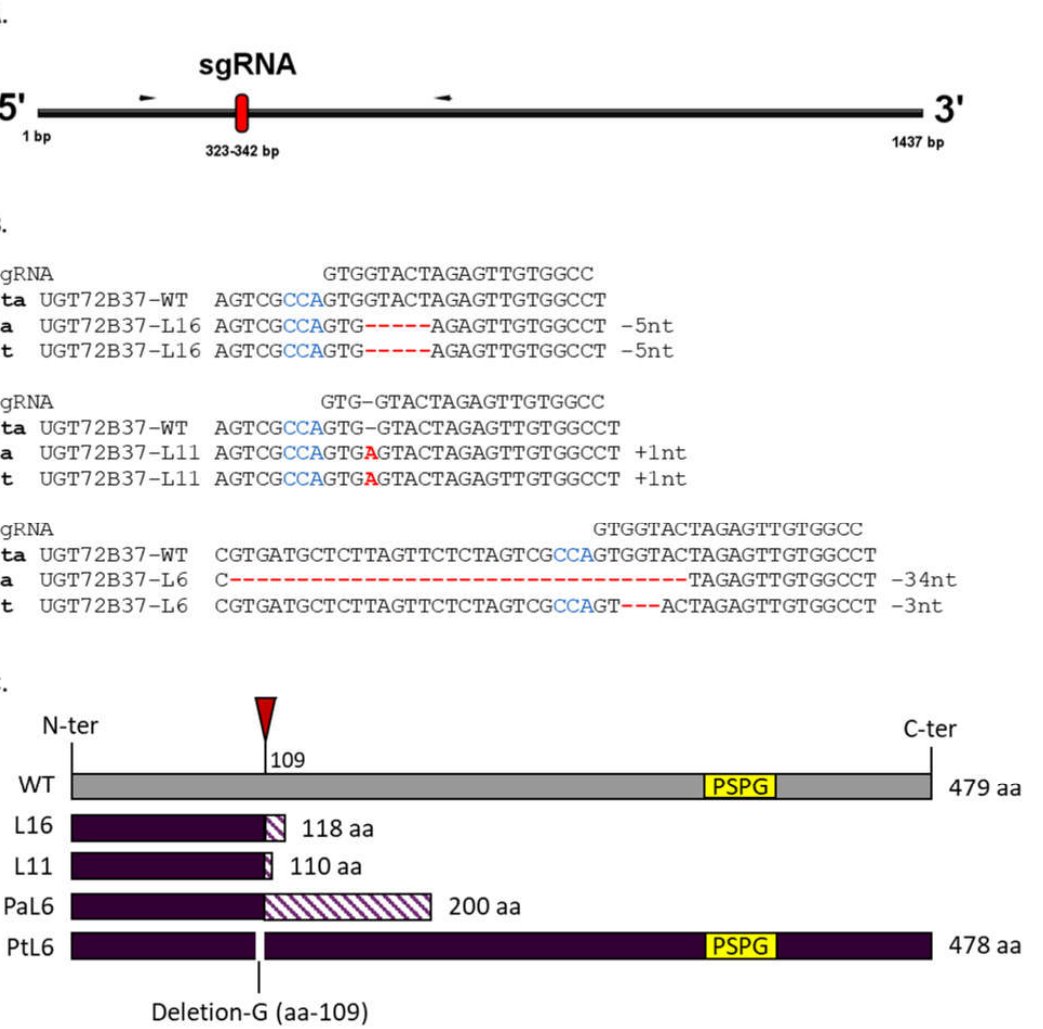
Figure 2. Production of transgenic poplars with CRISPR/Cas9-knockout of UGT72B37 : ( A ) location of the sgRNA target site and the amplified region for sequencing (black arrows, 507 bp in the WT); ( B ) genotypes of the ugt72b37 mutants used in this study. For each independent mutant line (L16, L11, and L6), the genomic modifications of the P. alba (Pa) and the P. tremula (Pt) alleles are indicated in bold red. The protospacer adjacent motif sequence is indicated in blue. The indel numbers are indicated on the right; and ( C ) length of deduced polypeptides from the WT and ugt72b37 mutant lines. The PSPG motif is highlighted in yellow. The red motives in A and C indicate the sgRNA target site. The purple stripes represent a polypeptide sequence with a frameshift.